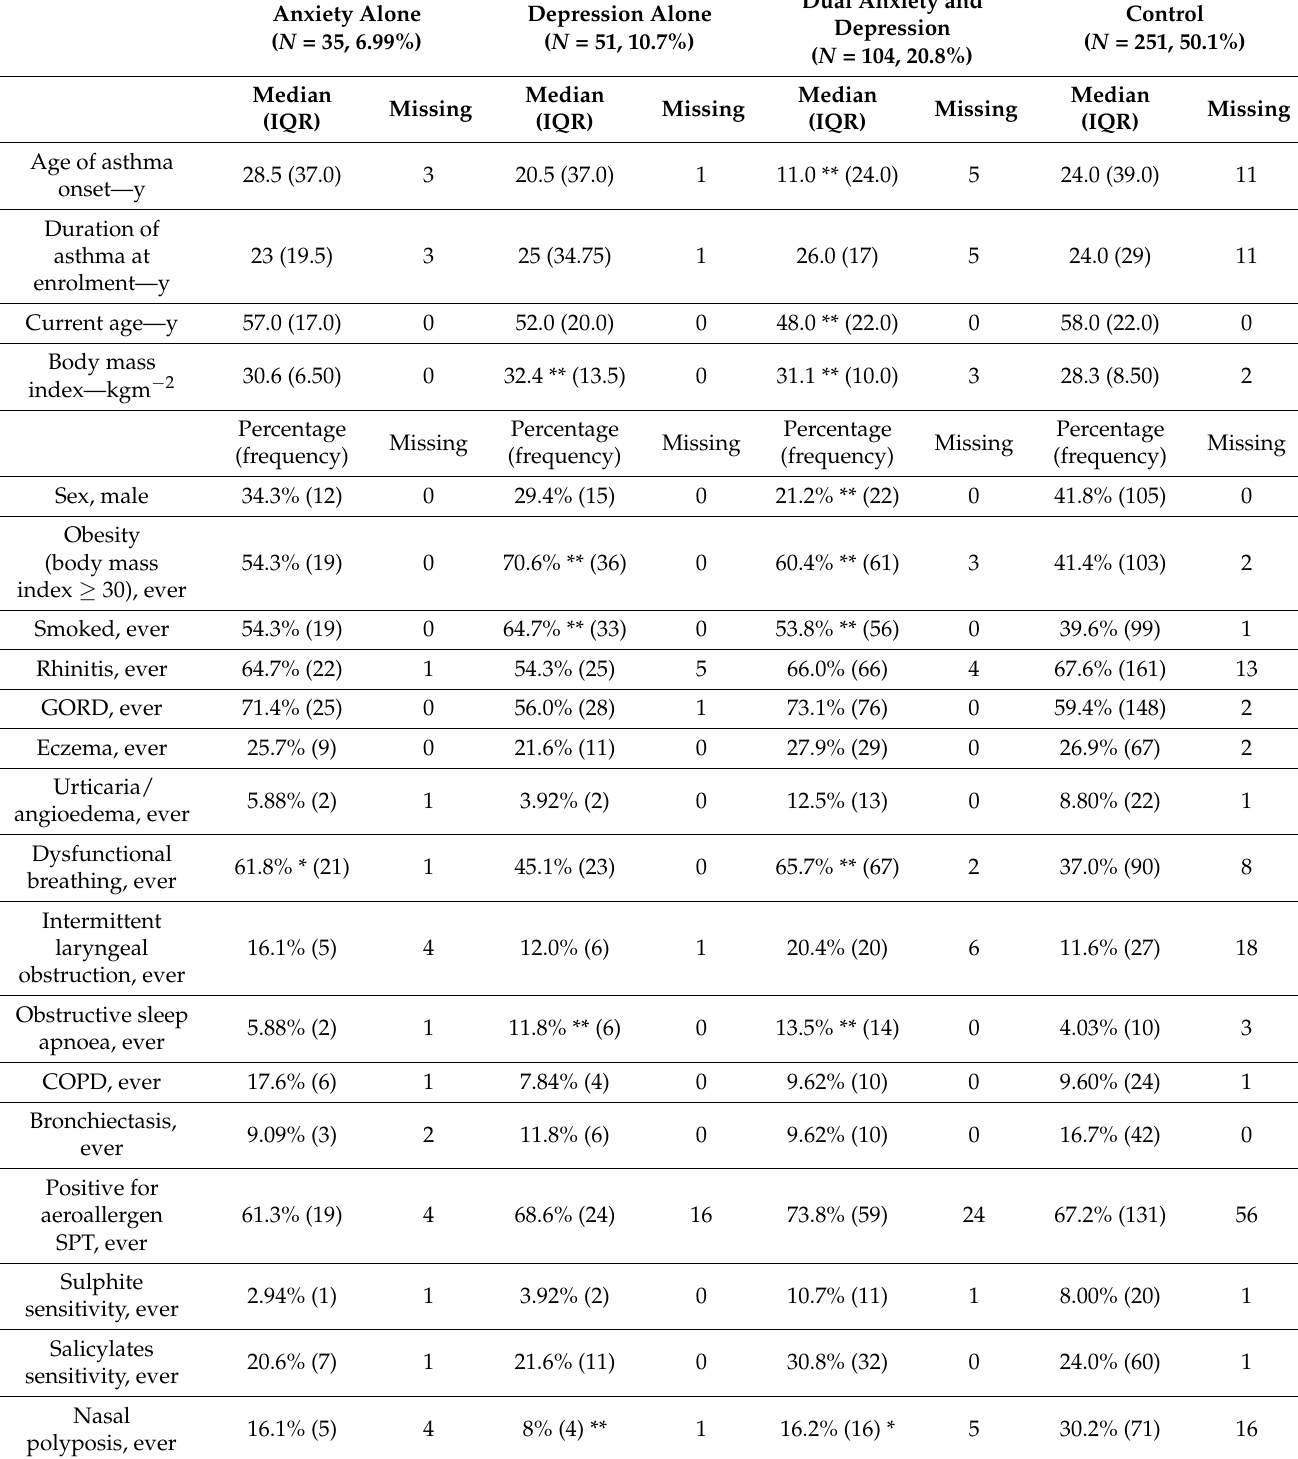
Table 1. Phenotypic characteristics of WATCH patients by clinical diagnoses of psychological